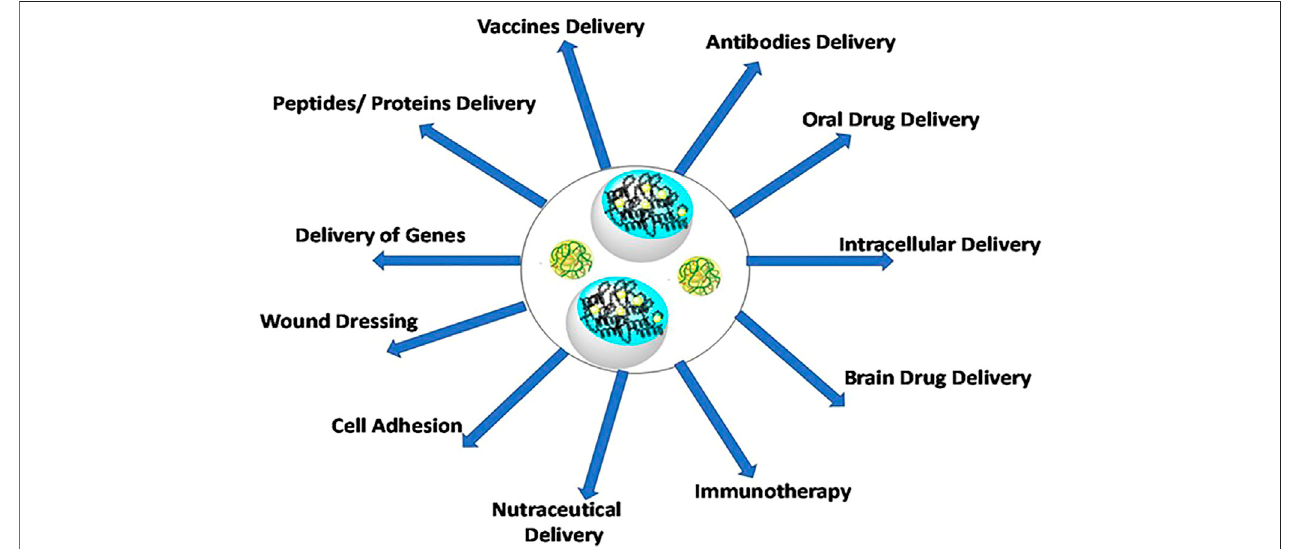
FIGURE 1 | Applications of protein nanohydrogels in delivery of bioactive and biopharmaceutic compounds.